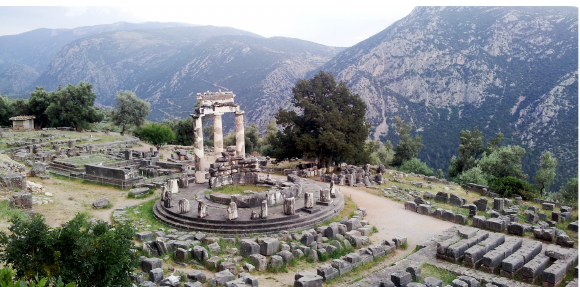
Figure 1: The Tholos in the Sanctuary of Athena Pronaia, Marmaria, Delphi, May 2014. The archaeological site of Delphi, located in Phocis